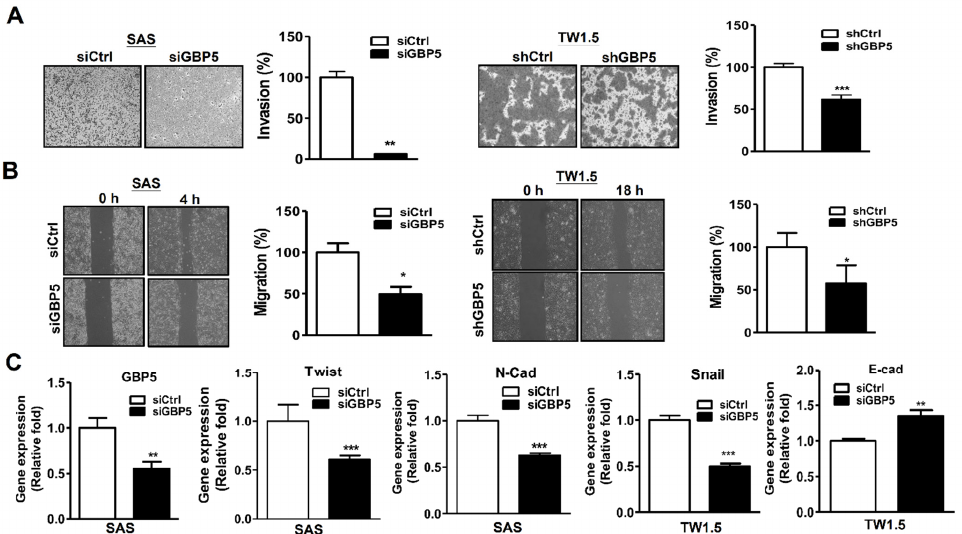
Figure 4. Effects of GBP5 in cell invasion and migration of OSCC cells. ( A ) Invasion of GBP5–silenced SAS and TW1.5 cells. ( B ) Migration of GBP5-silenced SAS and TW1.5 cells. ( C ) Gene expression levels of EMT-related markers in GBP5- silenced SAS and TW1.5 cells by RT-PCR. Transient GBP5 – silenced cells were cells transiently transfected with 10 nM scramble siRNA (siCtrl) or GBP5 siRNA (siGBP5) for 72 h. Stable GBP5-silenced cells were cells transfected with scrambled shRNA (shCtrl) or shRNA against GBP5 (shGBP5). All quantitative results are calculated as the mean ± SEM from three independent experiments. A value of p < 0.05 was considered significant (*** p < 0.001, ** p < 0.01, * p < 0.05).